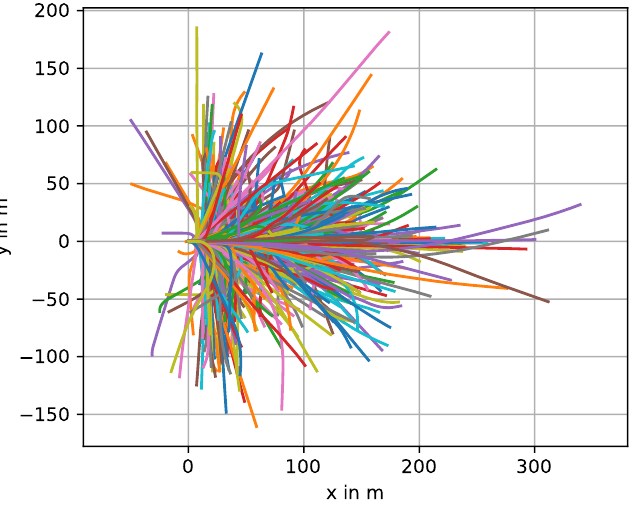
Figure 2. The coordinates projection of the trajectory data in the nuScenes data set. All trajectories were rotated and translated to begin at the origin with zero initial yaw angle for this